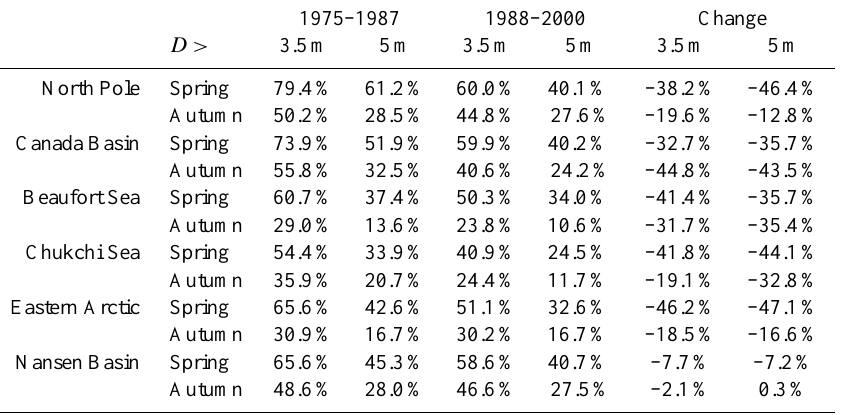
Table 4. Fractional volume of the ice in category 3 defined using two different draft limits, D > 3 . 5m and D > 5m, in Spring and in Autumn during the periods 1975–1987 and 1988–2000, and the percentage change of the volume between the